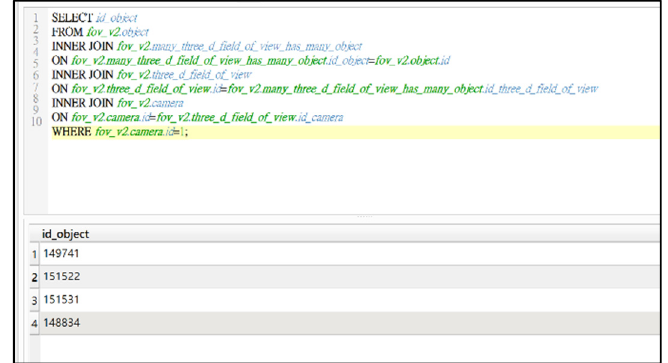
Figure 13. Single system of CCTV’s coverage Building ID.